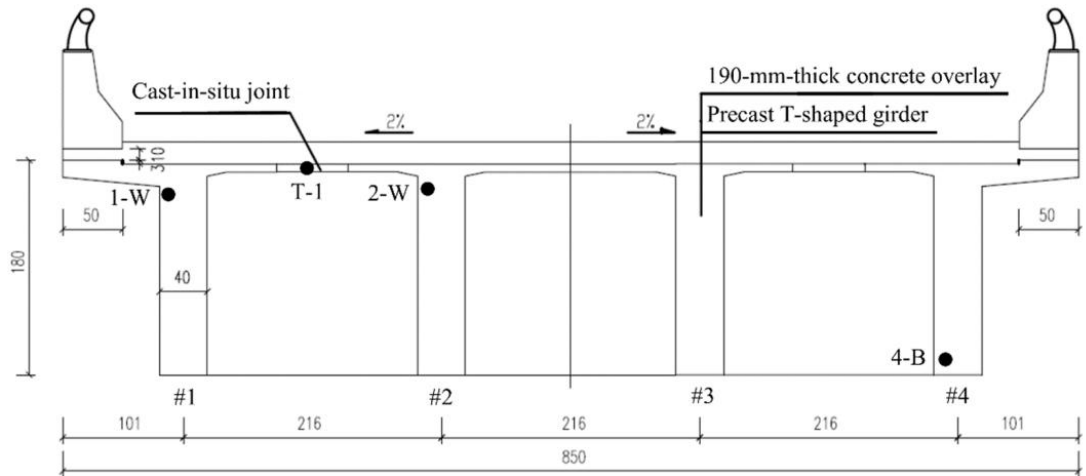
Figure 19. Layout of cross-section of T-shaped girder (cm).